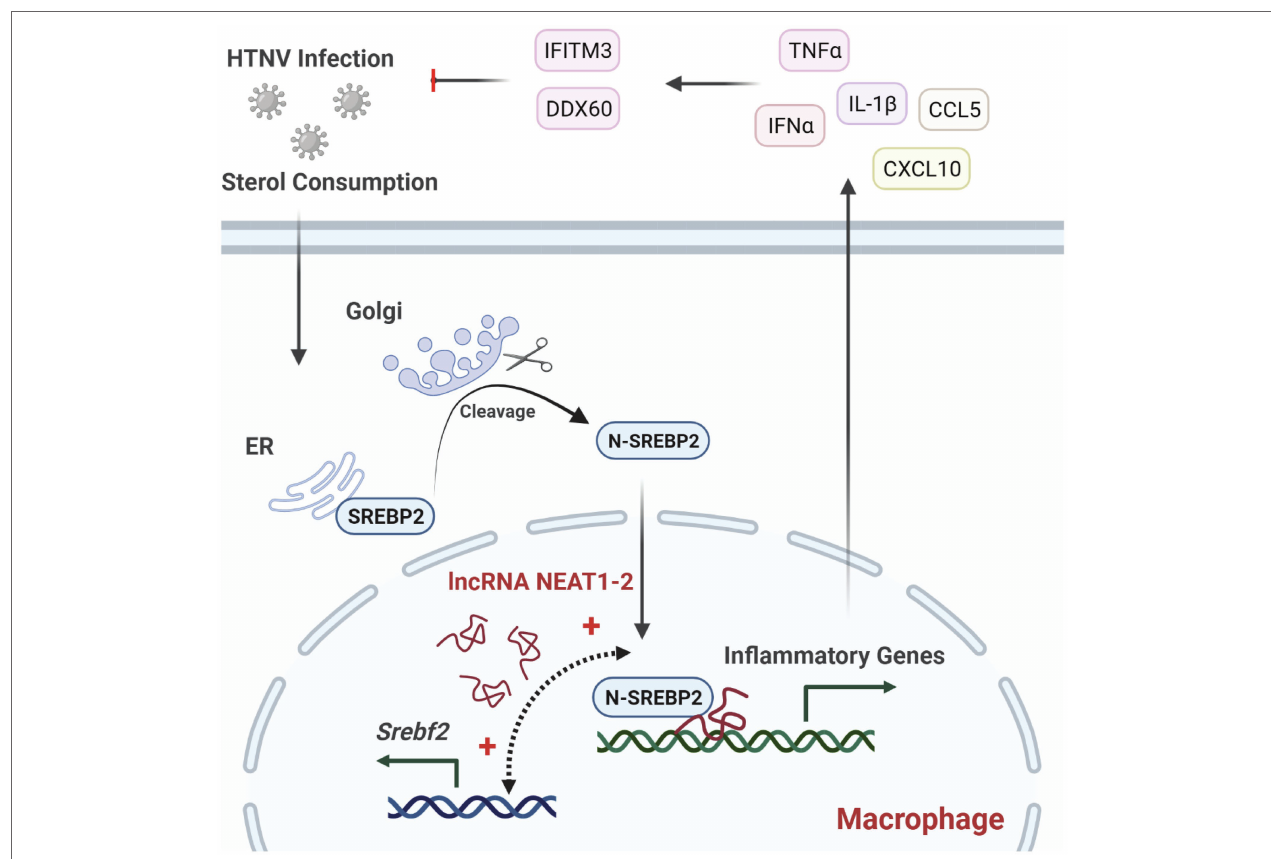
FIGURE 7 | Regulation of NEAT1-2 in SREBP2-mediated Anti-hantaviral Macrophage Responses. HTNV infection consumes cellular sterols and activates the SREBP2 pathway in macrophages, during which lncRNA NEAT1-2 potentiates SREBP2 activity by facilitating Srebf1 expression and initiating SREBP2-mediated inflammation. M1-type macrophages further stimulate host antihantaviral responses by secreting multiple cytokines, including IFN α , TNF α , and IL-1 β . These cytokines promote the expression of antiviral molecules such as IFITM3 and DDX60, thus restricting HTNV replication and